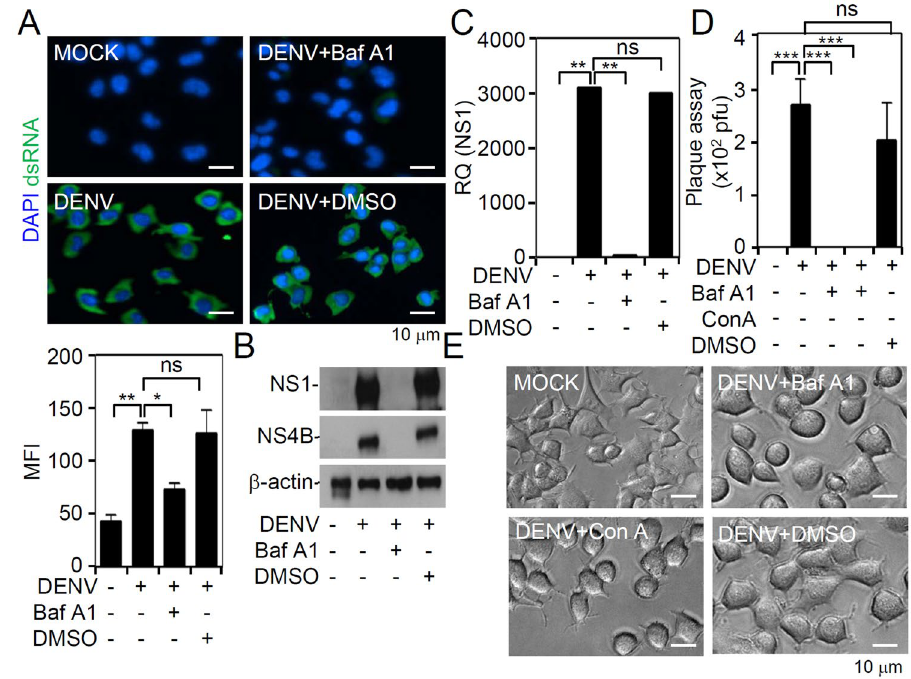
Figure 3. Inhibition of endosomal acidification effectively abolishes dengue virus serotype 2 (DENV2) infection in vitro . Neuro-2a cells were inoculated with DENV2 (at a multiplicity of infection of 1) for 24 h in the presence of the V-ATPase inhibitor, bafilomycin A1 (BafA1; 100 nM) or concanamycin A (ConA; 50 nM). ( A ) Immunocytochemistry and the relative mean fluorescence intensity ( MFI ) of viral dsRNA ( green ). ( B ) Western blotting analysis shows viral NS1 and NS4B expressions. The relative ratio to β -actin is shown. ( C ) qPCR shows the mRNA expression of NS1. ( D ) Plaque assays show the level of viral replication. ( E ) Cell morphology of DENV2-infected cells. For all images, representative data were selectively obtained from three individual experiments. Quantitative data are depicted as the mean ± SD of three independent experiments. * p < 0.05, ** p < 0.01, and *** p < 0.001. ns, not significant.